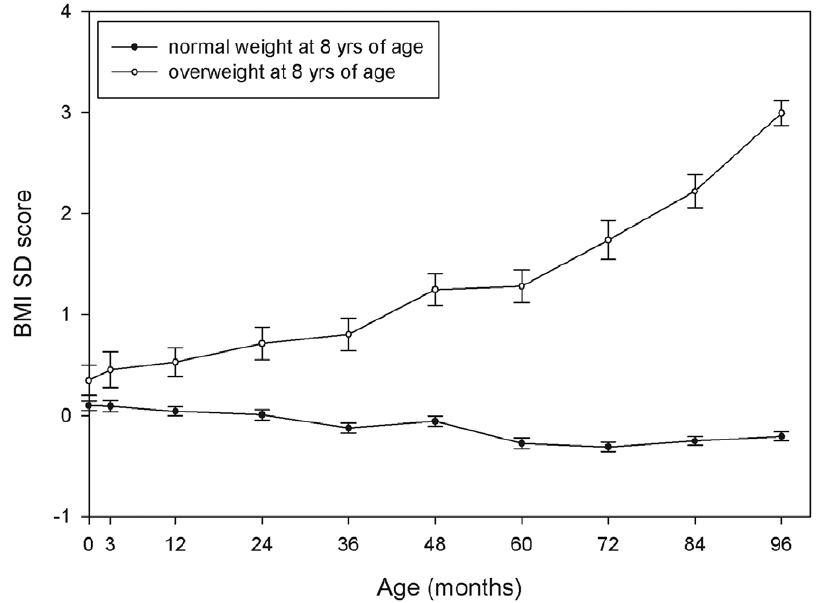
Figure 2. Mean (95% CI) BMI SDS from birth to 8 years (96 months) of age for normal weight versus overweight children at 8 years of age.